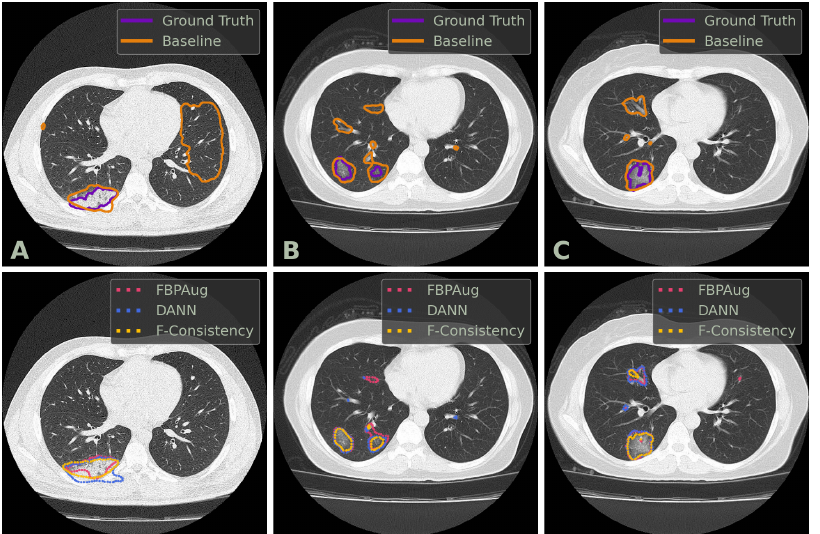
Figure 2. Examples of axial CT slices from the COVID-test dataset with the corresponding predictions and ground truth annotations. Three columns, denoted ( A – C ), contains three unique slices. The top row contains the contours of the ground truth and baseline prediction. The bottom row contains the contours of the adaptation methods’ predictions. DANN and F-Consistency correspond to DANN and F-Cons from Table 3,